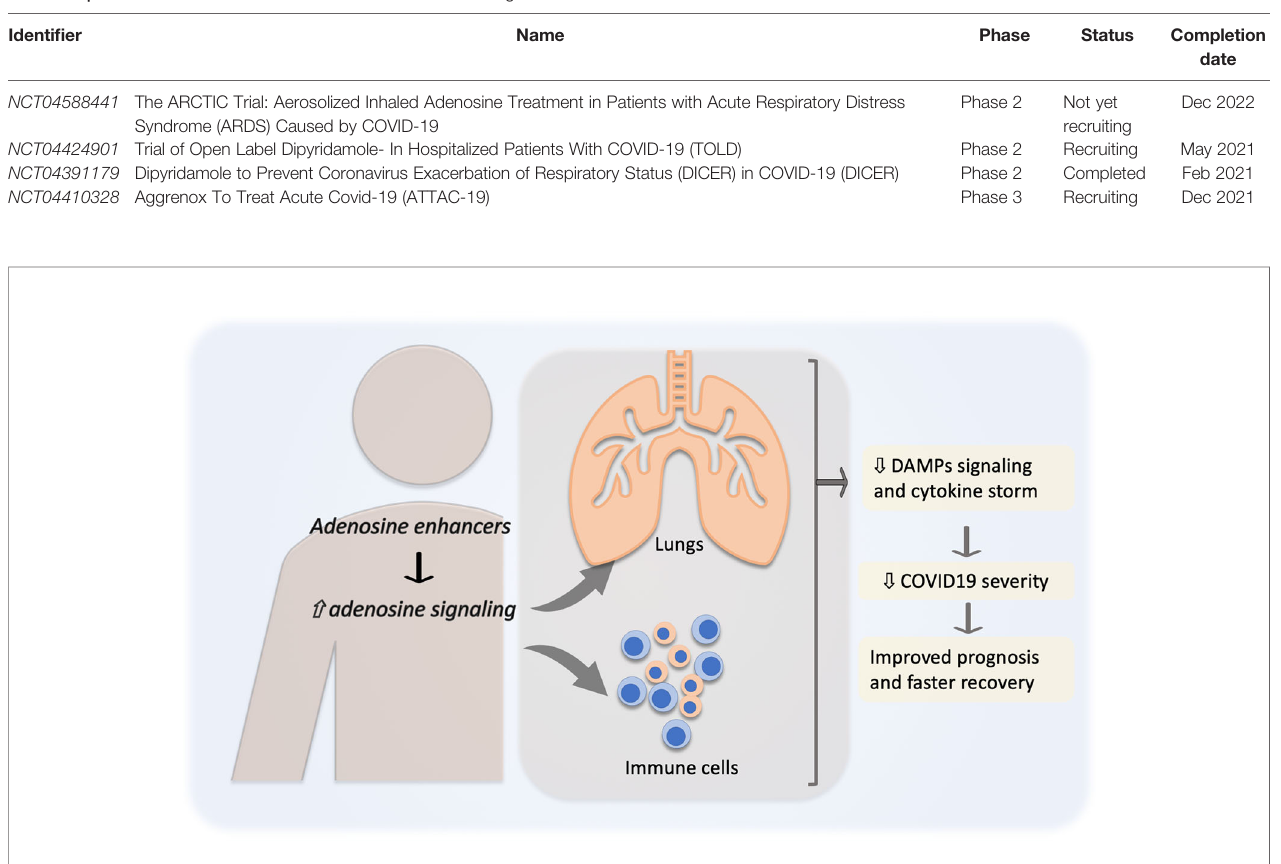
FIGURE 3 | Adenosine in the reduction of COVID-19 severity. Pharmacological regulation of adenosine level and signaling, for instance by adenosine uptake inhibition or adenosine receptor agonists, will lead to adenosine signaling enhancement ( ⇧ ) resulting in a decreased ( ⇩ ) danger-associated molecular patterns (DAMPs) signaling and “ cytokine storm ” . All this together might result in a decreased severity and better prognosis for COVID-19